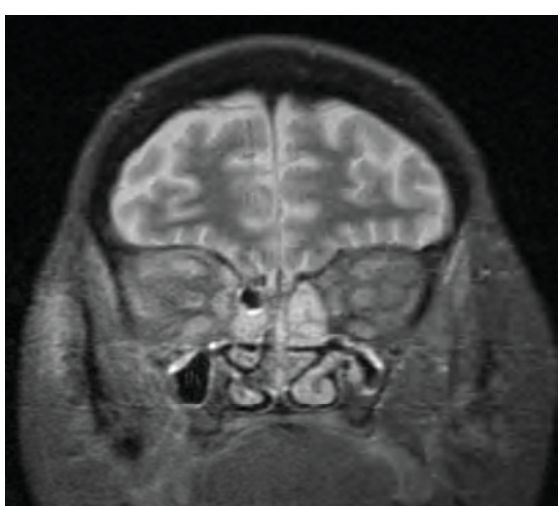
Figure 3. MRI of paranasal sinuses and orbits, coronal section: Both-sided infiltration of the ethmoids and retrobulbar